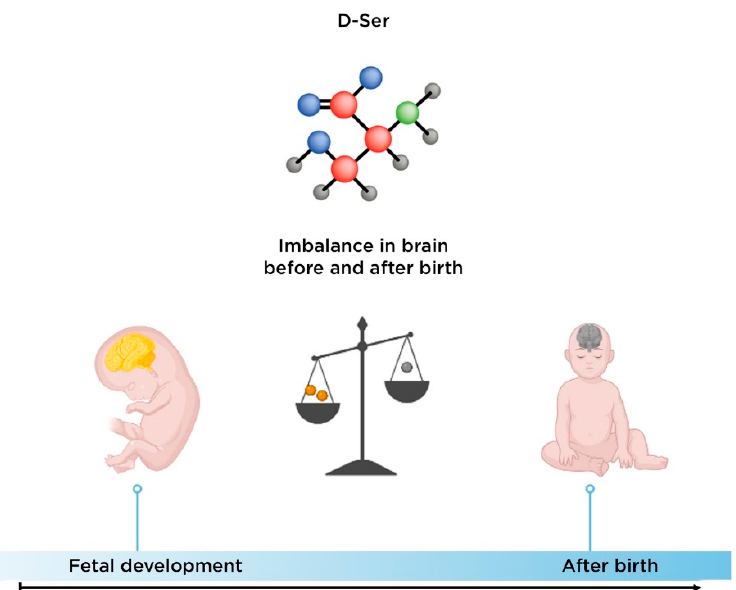
Figure 6. Change in D-serine in the human brain during ontogenesis. Notes: insufficiently studied in endocrine tissue.